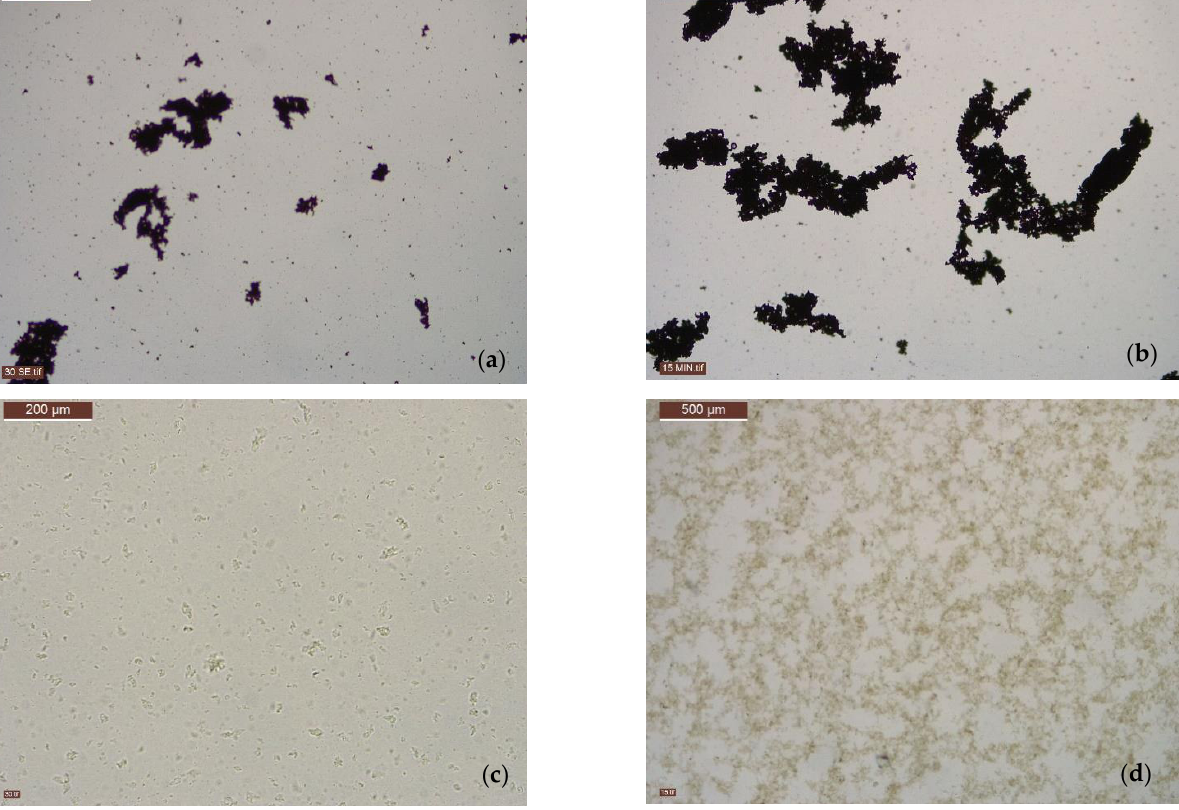
Figure 7. Optical micrographs for sulfide precipitates obtained by Gim-Krumm and colleagues [49] at pH 3.5 with a 1.2 sulfide/metal molar dosage. ( a ) copper at 30 s; ( b ) copper at 15 min; ( c ) zinc at 30 s; ( d ) zinc at 15 min.